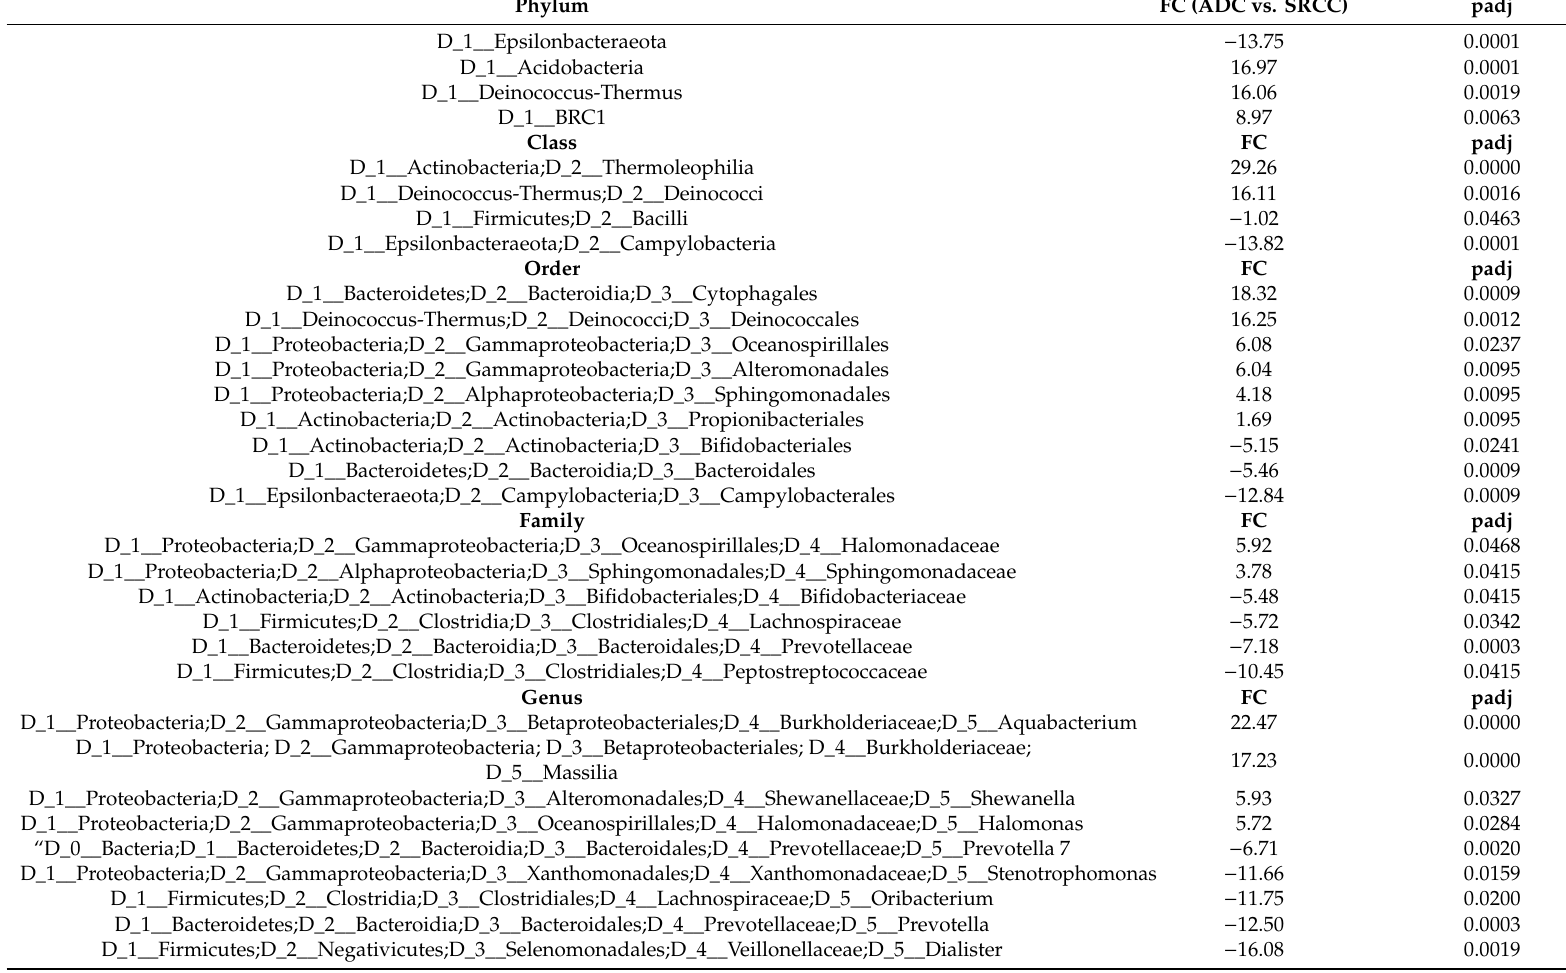
Table 1. Di ff erence in abundance in microbial communities at the phylum, class, order, family and genus taxonomic